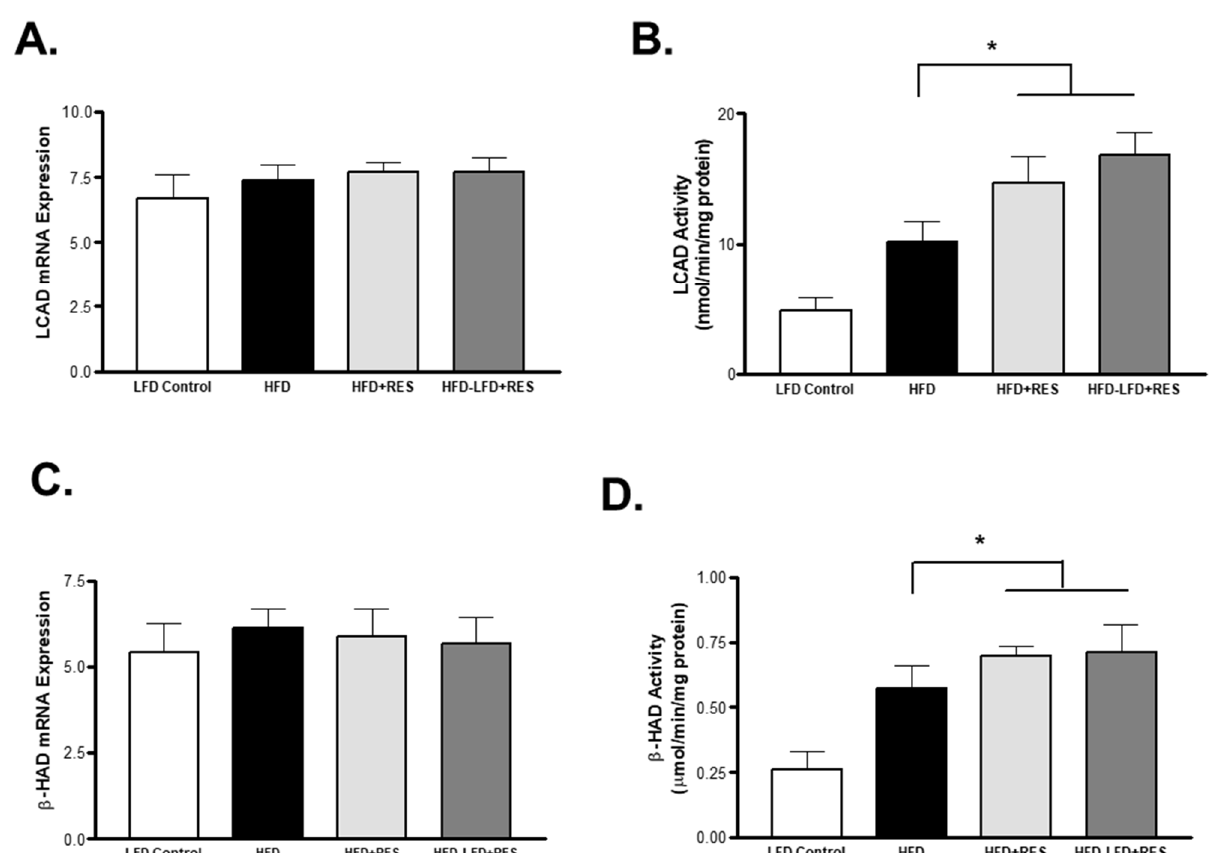
Figure 3. Effects of diet and resveratrol treatment on fatty acid oxidation enzymes. ( A ): LCAD mRNA expression. ( B ): LCAD enzyme activity. ( C ): β -HAD mRNA expression. ( D ): β -HAD enzyme activity. * p < 0.05 vs. HFD. Values represents mean ± S.E.M. (n = 6–8).